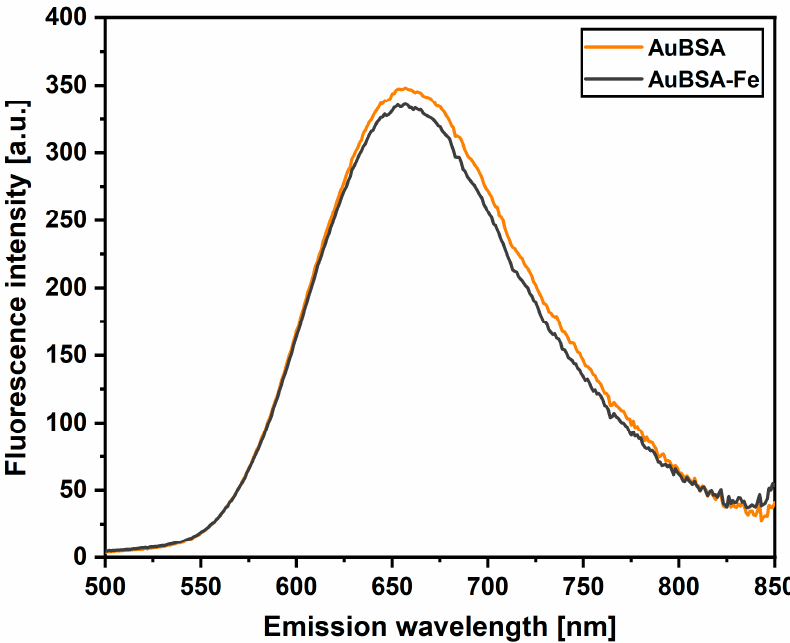
Figure 2. Comparison of fluorescence emission spectra of AuBSA (orange curve) and AuBSA-Fe (black curve) samples when excited at 480 nm. Average fluorescence spectra are shown as a result of seven independent sample preparations and their measurements.